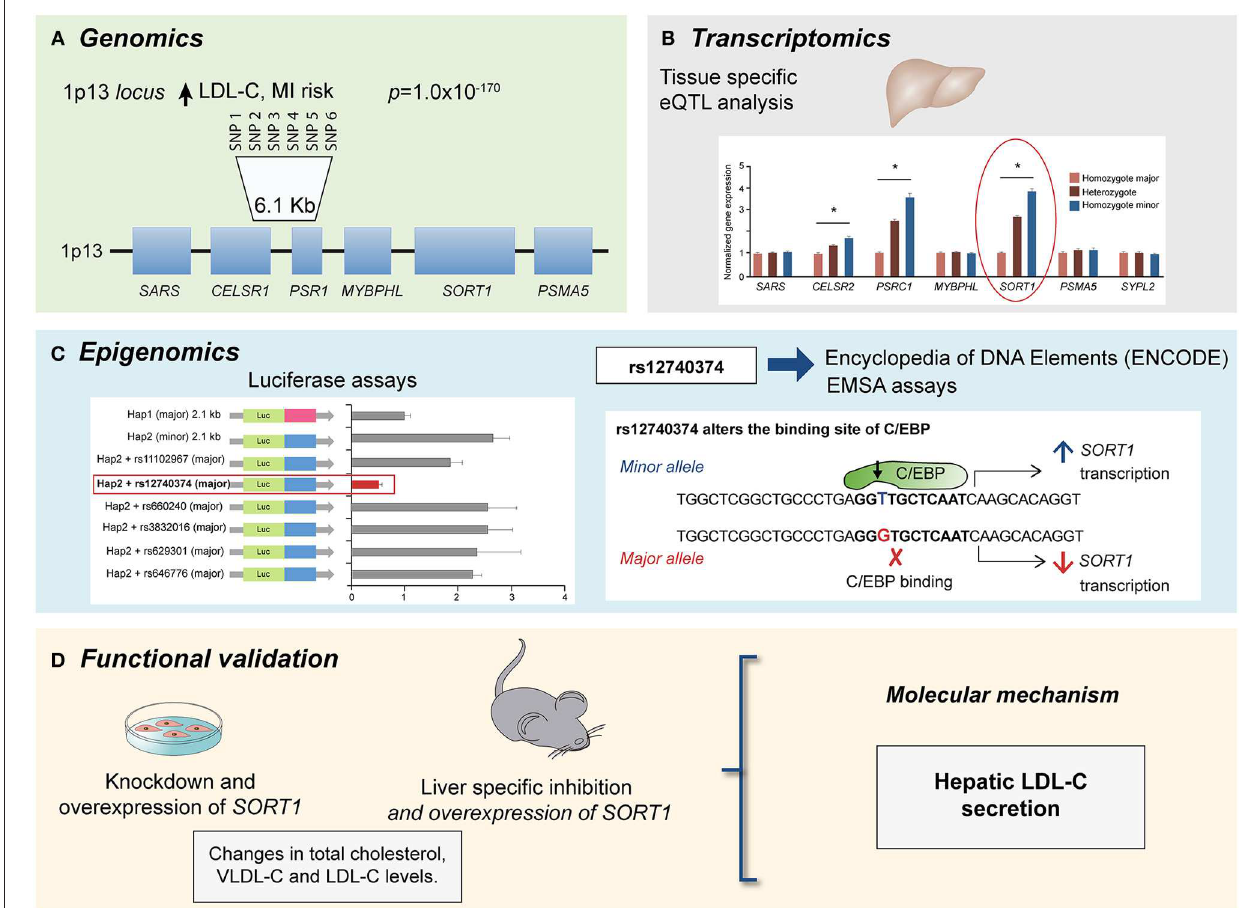
FIGURE 1 | Multi-omics approach to identify the causal gene associated with LDL-C levels and CAD risk at the 1p13 locus. (A) GWAs meta-analysis showed several SNPs at the 1p13 locus strongly associated with LDL-C levels ( p = 1.0 × 10 − 170 ) and CAD risk. The 1p13 locus contains several genes (squares). The most significantly associated haplotype for LDL-C comprise six SNPs in high linkage disequilibrium (LD) and is located between CELSR1 and PSR1 genes. (B) Liver eQTL analysis showed the minor haplotype significantly associated with higher expression of CELSR1 , PSR1 , and SORT1 genes with SORT1 gene showed the largest difference modified from Musunuru et al. (74). (C) By using luciferase assays and ENCODE database it was identified a common polymorphism at the 1p13 locus, rs12740374 that alters the expression of the SORT1 gene in liver with the minor allele (T) creating a C/EBP (CCAAT/enhancer binding protein) transcription factor binding site and the major allele (G) disrupting it. The C/EBP transcriptional factor regulates the expression of hepatic genes involved in metabolism. (D) Functional approaches for SORT1 using small interfering RNA (siRNA) knockdown and viral overexpression in mouse liver showed that SORT1 results in significant changes in plasma LDL-C and very low-density lipoprotein (VLDL) particle levels by modulating hepatic VLDL